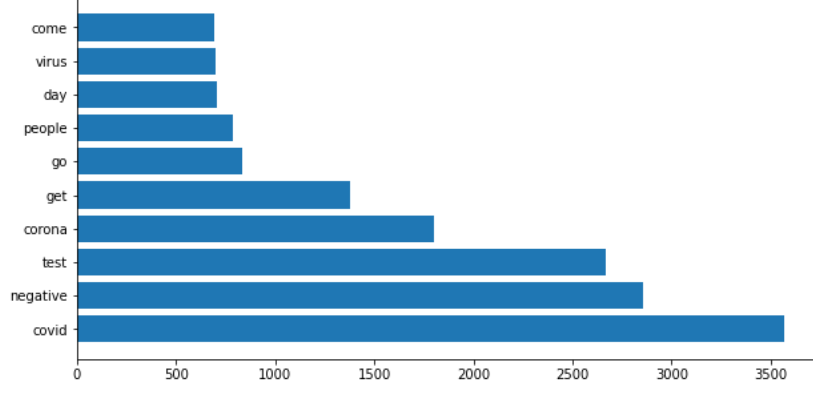
Figure 3. Most frequent words for negative class.